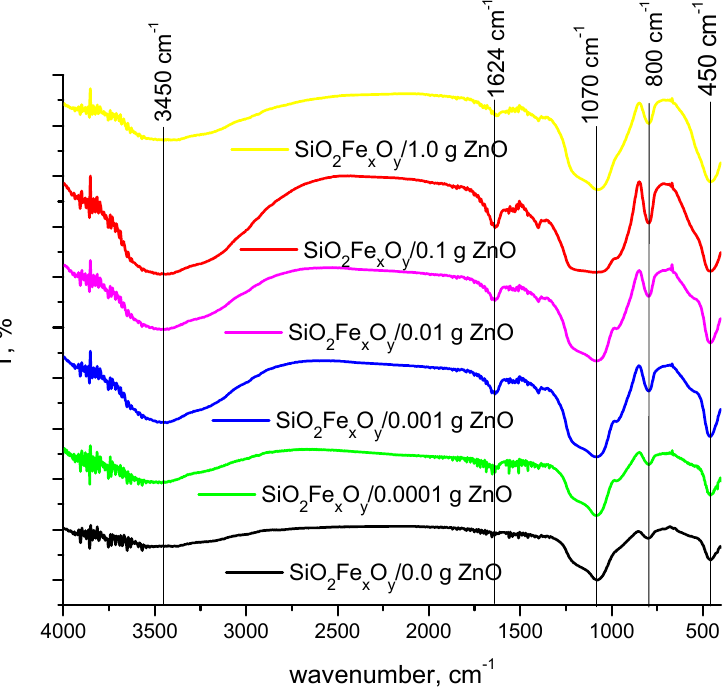
Figure 2. Fourier-transform infrared spectroscopy (FT-IR).